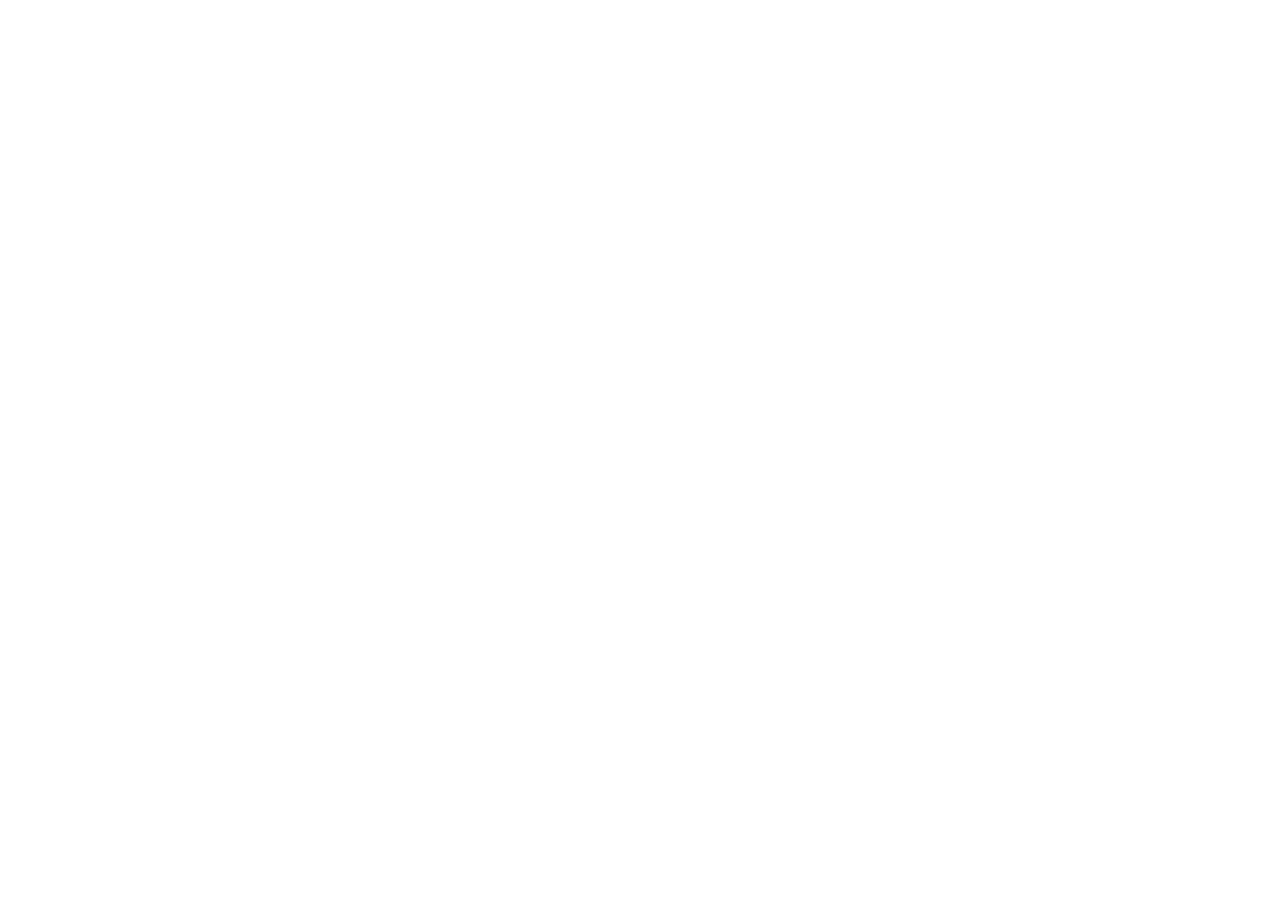
FIGURE 1 | Estimated IBI trajectories for the two profiles. The first profile characterized 109 topic-couple combinations, while the second characterized 24. For indistinguishable dyads, the distinguishing variable A/B was randomly assigned and should not be interpreted. Predicted trajectories for Profile 1: The Simple Profile. Predicted trajectories for Profile 2: The Complex